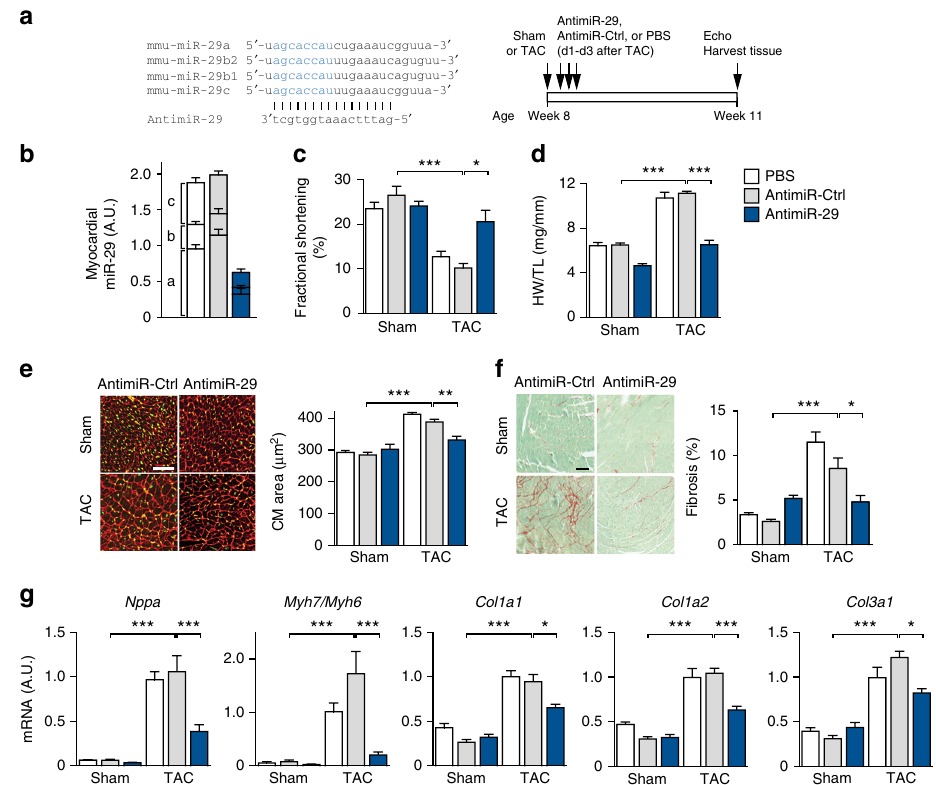
Fig. 2 Pharmacological inhibition of miR-29 prevents cardiac remodeling and dysfunction. a (Left) Design of the miR-29 family inhibitor (antimiR-29). Sequences of miR-29a, b1, b2 and c display a high degree of sequence similarity with identical seed regions (depicted in blue), thus permitting the design of a single antimiR molecule. (Right) Design of the study. b Cardiac expression of miR-29 family members in mice, determined weeks after the fi rst injection of antimiR-29, a control molecule (antimiR-Ctrl) or PBS. c Echocardiographic analysis of left ventricular fractional shortening in sham-/TAC-operated mice 3 weeks after injection with antimiR-29/-ctrl or PBS (determined by echocardiography), indicating reduced TAC effects in the antimiR-29-treated group. d Heart weight-to-tibia length ratio and e WGA staining of left ventricular tissue from mice described in c for determination of cardiac and CM hypertrophy. f (Left) Representative left ventricular sections stained with Sirius Red/Fast Green of the indicated treatment groups and (right) quanti fi cation of interstitial fi brosis. g Quantitative real-time PCR analysis of molecular markers for cardiac myocyte hypertrophy ( Nppa , Myh7/Myh6 ) and of fi brosis-associated collagens. All scale bars: 50 µ m. All quanti fi cations derive from n = 5 – 14 mice/group, PCR performed with 2 replicates each. All quantitative data in panels c – g are reported as means ± SEM. * P < 0.05, ** P < 0.01, *** P < 0.001 determined by two-way ANOVA followed by Bonferroni ’ s post hoc